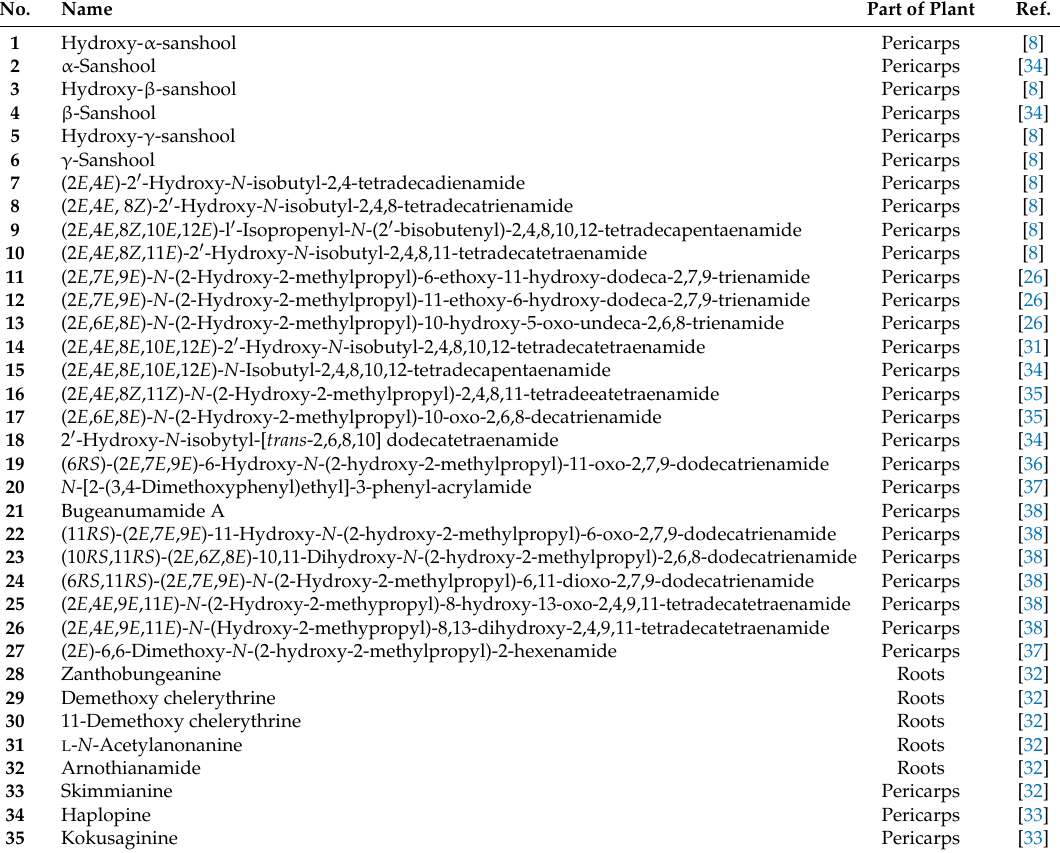
Table 2. Alkaloids isolated from Z. bungeanum ( 1 – 35